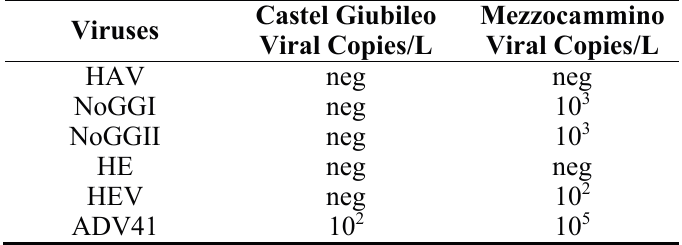
Table 3. Environmental results from the Castel Giubileo and Mezzocammino sites using q-PCR (Hepatitis A Virus: HAV; Norovirus GGI: NoGGI; Norovirus GGII: NoGGII; Human Enterovirus: HE; Hepatitis E Virus: HEV; Adenovirus 41: ADV41). Copies converted to 1 L of water are reported in the respective columns. Negative sample: